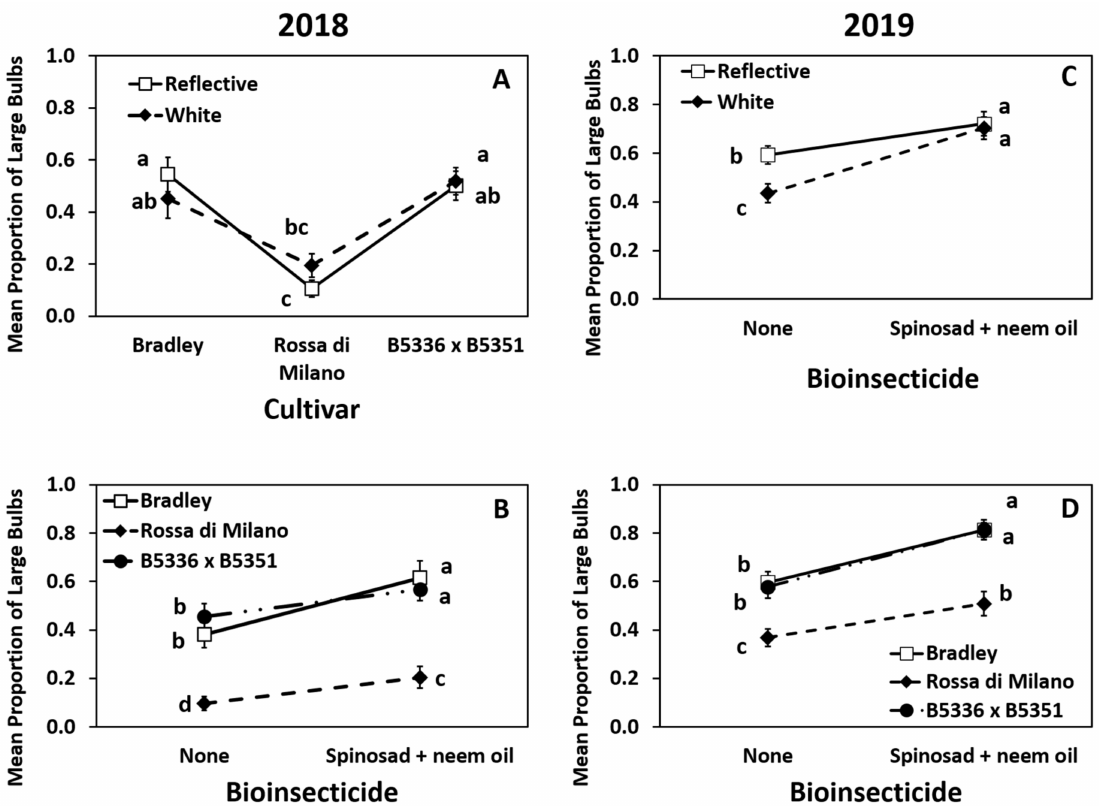
Figure 4. Highest order significant effects of the interactions of mulch × cultivar ( A ), cultivar × biopesticide ( B , D ), and mulch by biopesticide ( C ) on mean ( ± SE) proportion of large onion bulbs (diameter >7.3 cm) in 2018 ( A , B ) and 2019 ( C , D ) in Geneva, New York, USA. The standard errors at some time points are small and may appear behind the point marker. Means with different letters are significantly different at α = 0.05 using Tukey’s LSD post hoc